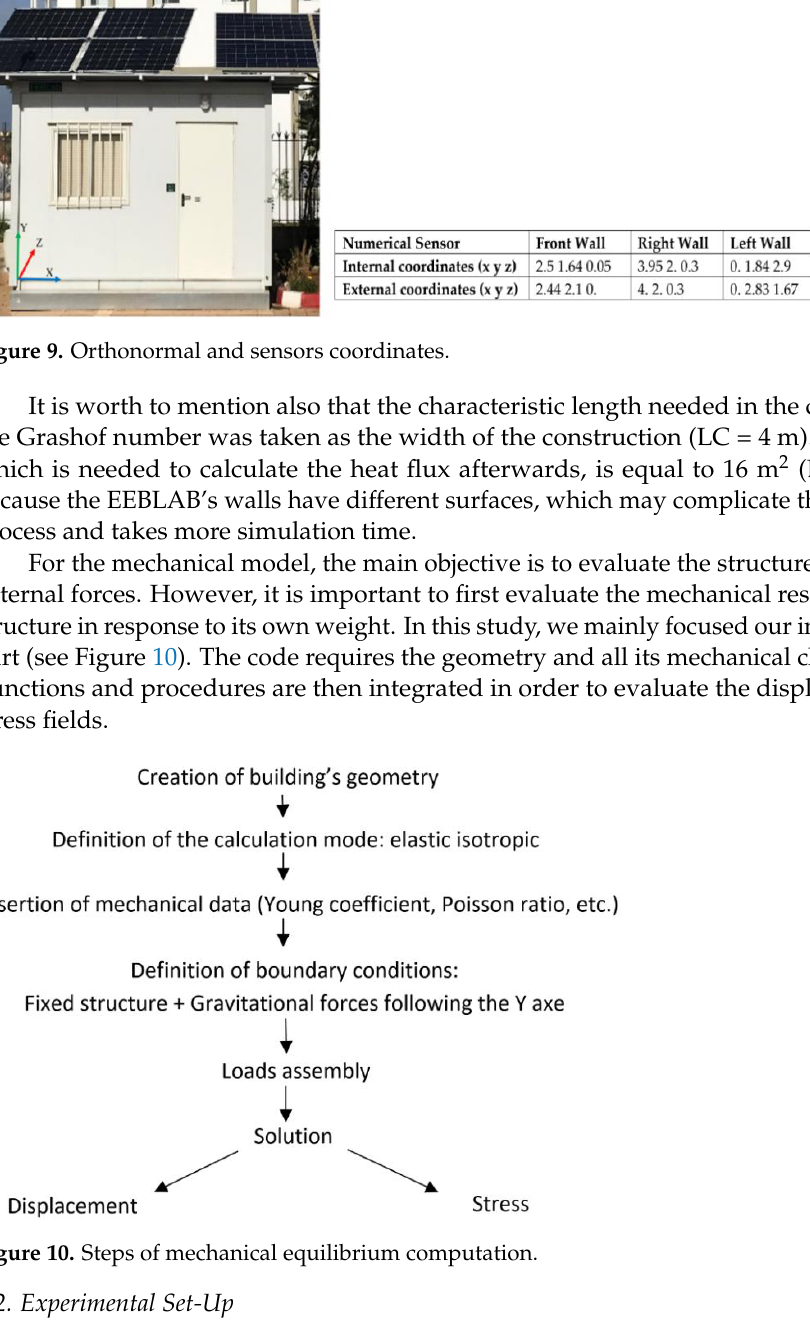
Figure 8. Weather data for the city of Sala EL Jadida during March 2019 [30].